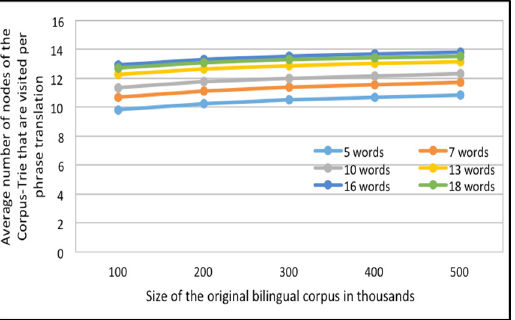
Figure 8. Average number of nodes of the Corpus-Trie that are visited per phrase translation ver- sus Size of the original bilingual corpus in thousands, for the English-French